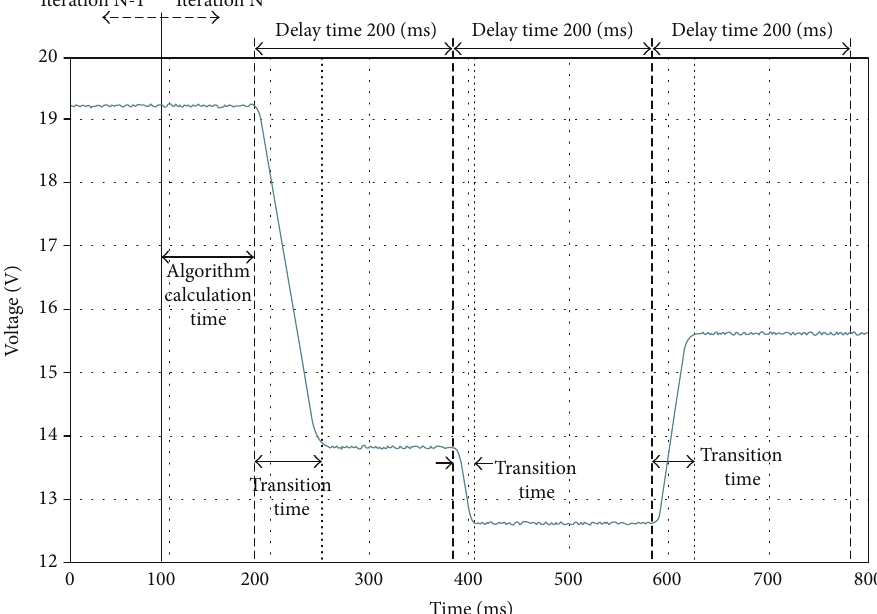
Figure 11: Execution procedure of one iteration and delay time setting for each voltage adjustment. Table 11: Irradiance setup of the 6 evaluation patterns (W/m 2